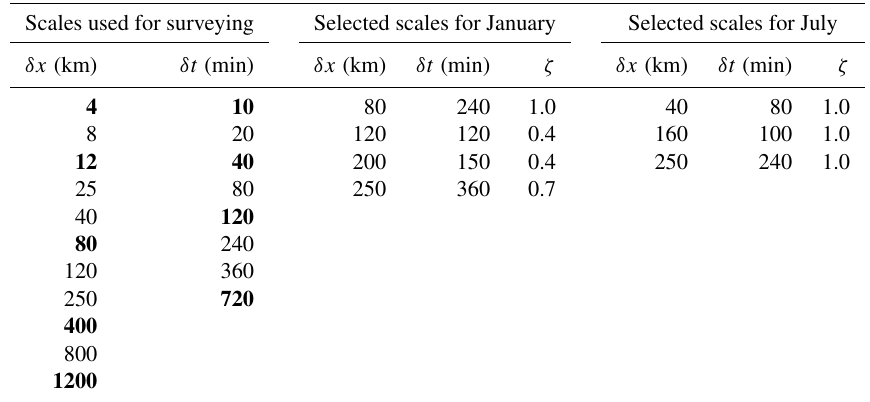
Table 1. Surveyed and selected spatial and temporal scales ( δx , δt ) as well as intermittency factor ( ζ ) for the Yonsei CGWS scheme. Spectra corresponding to the values given in bold are shown in Fig. 1. Scales used for surveying Selected scales for January Selected scales for